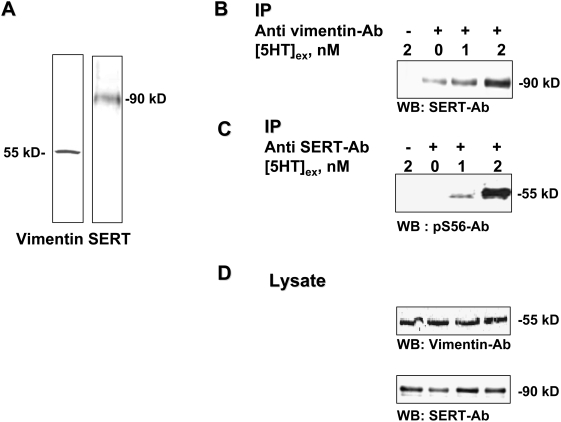
SERT and vimentin interaction in human platelets.
(A) Endogenous vimentin and SERT expression in platelets were analyzed with W/B analysis. The association between vimentin and SERT was determined by a co-IP in platelets stimulated with 0, 1, and 2 nM 5HT. Following 5HT-stimulation, platelet lysate was divided into two portions; the half portion of lysate was incubated in anti-vimentin monoclonal Ab (B), the other half portion in anti-SERT Ab coated protein A Sepharose beads (C). Next day, vimentin- or SERT-Ab pulled down proteins were eluted from sepharose beads; both IP eluents were analyzed either with a polyclonal SERT Ab, or with pS56-Ab, respectively. Nonspecific adsorption of Sepharose beads was not determined in the absence of antibodies. The association between endogenous vimentin and SERT was altered in a 5HT concentration-dependent manner. The highest amount of SERT was pulled down by vimentin-Ab in 2 nM 5HT-stimulated platelets. Additionally, vimentin associated with SERT after 2 nM-5HT stimulation was in phosphorylated form. (D) Expression of SERT and vimentin in total cell lysates was determined by W/B analysis as a loading control. All lanes contain protein recovered from the same number of platelets (1.5×108). Figures show representative images from 2 to 4 separate experiments.